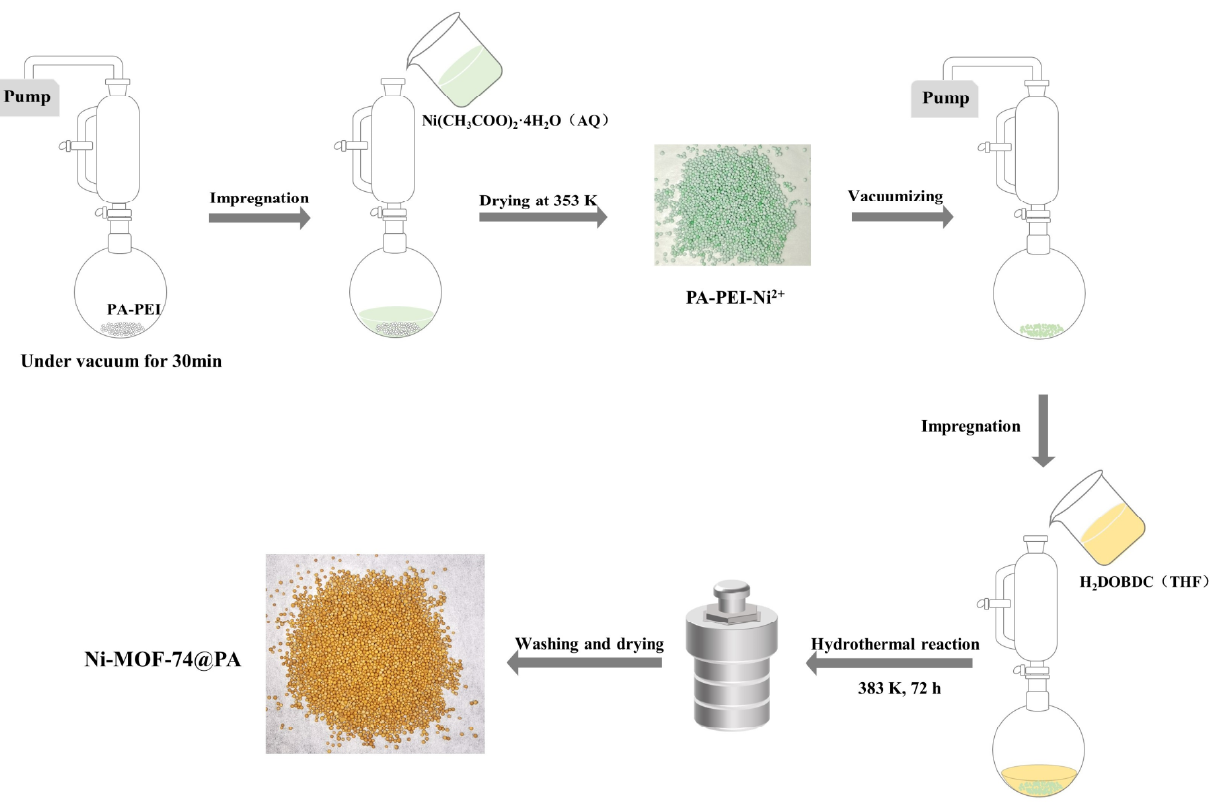
Figure 2. Schematic of the preparation of Ni−MOF−74@PA−PEI.